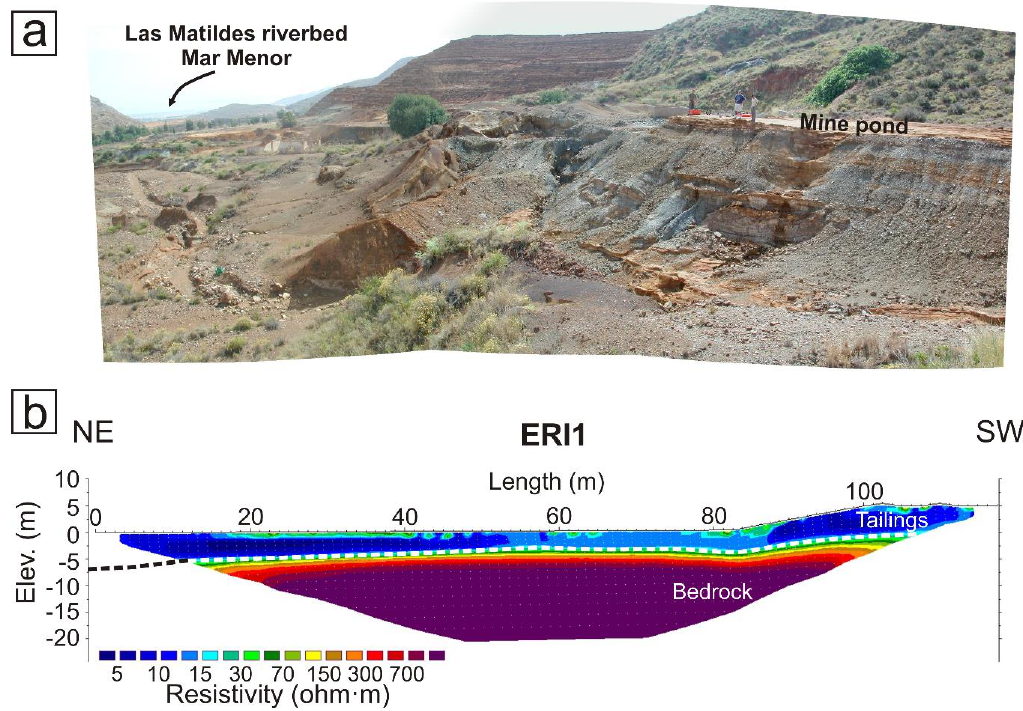
Figure 3. Descargador mine pond: ( a ) general view of the non-eroded remaining tailings; ( b ) ERI profile showing the two identified units.